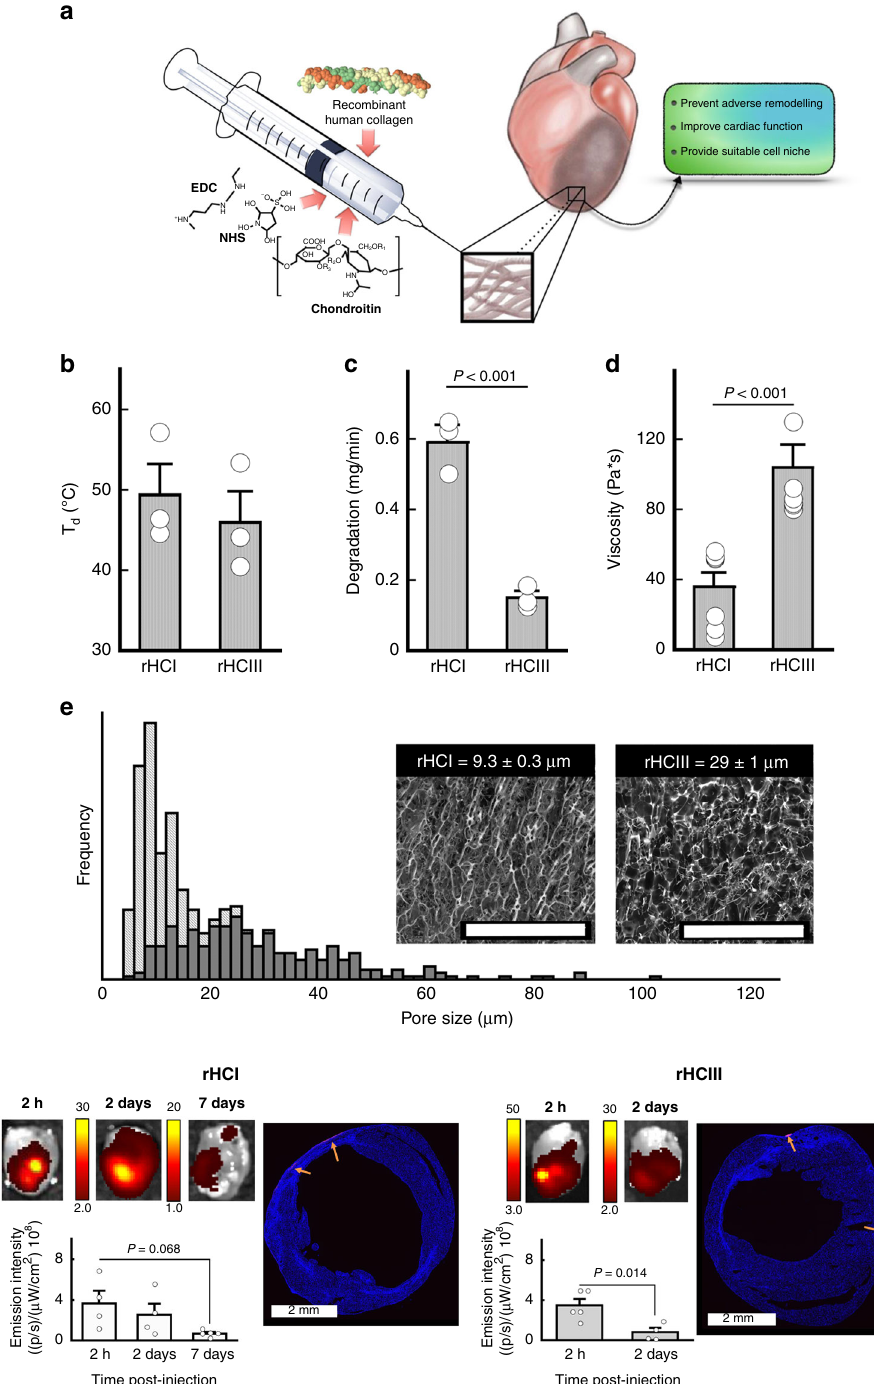
Fig. 1 Preparation and physical characterization of injectable rHC matrices. a Schematic depicting the components, delivery, and reparative properties of the injectable material presented in this study. b Denaturation temperatures ( T d ) (°C; n = 3), ( c ) in vitro degradation in collagenase (mg/min; n = 3), and ( d ) viscosity measurements (Pa·s; n = 7) for rHCI and rHCIII matrices. e Pore size distribution for the rHCI (gray bars) and rHCIII (black bars) matrices calculated from 250 individual pores per sample. Inset: Representative Cryo-SEM images of the rHC matrices. Scale bar = 200 µ m. f Representative images of ex vivo imaging of MI mouse hearts at 2 h, 2 days, or 7 days, after treatment with the rHC matrices, labeled using Alexa-Fluor ® 594-NHS dye. Bottom histograms display the average total fl uorescence emission for the different time points ( n = 4). Also shown are representative histological sections of the myocardium at 2 days post injection. Arrows indicate representative regions containing the collagen matrices labeled with the fl uorescent dye. P- values were determined by a two-tailed t test. For b – d , ± data are presented as the mean ± SD and in f ± corresponds to SEM. Source data are provided as a Source Data fi le. For b – e , n indicates number of hydrogel batches. For f , n is the number of mice per